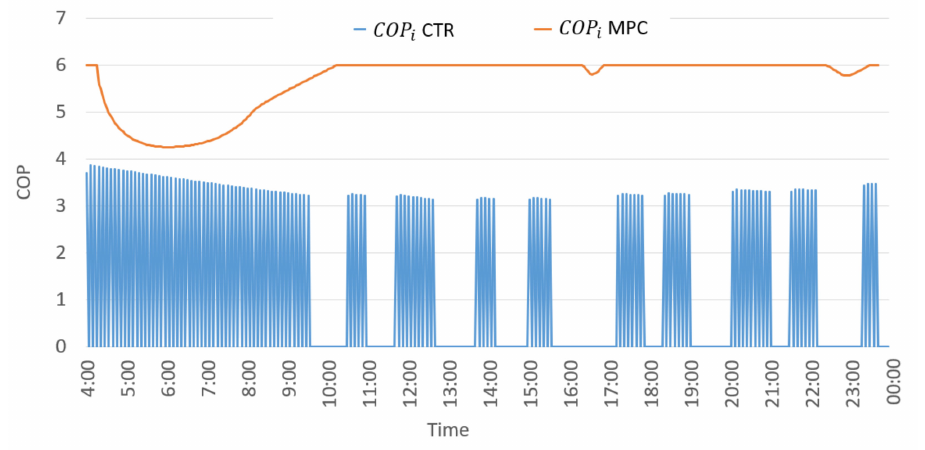
Figure 11. COP i values in the MPC vs. reactive methods (RM). In Figure 12, the behavior of the state variables T g associated with the indoor temper- i ature are displayed for different values of the parameter γ in the MPC and of parameter crt in the reactive method (RM). Imposing small values of the control parameter crt in the reactive method, Equation (12), the T g fluctuation is reduced in time and in extension i (see, as an example, T g in RM for crt = 0.2). In those cases, the HP activation is reduced, i decreasing the energy consumption but, also, leading to a failure in keeping track of the temperature during most of the time horizon. Besides, the comparison between the MPC approach and reactive method performance was carried out by varying the weighted parameters in the multiobjective optimization control model. In particular, the controller design based on the weighted sums of the three objectives in the optimization model was decomposed in its components. The two approaches were evaluated with respect to the second ( OBJ 2, Equation (1b)) and the third objectives ( OBJ 3, Equation (1c)), respectively, associated with the minimization of the electric power Pel i and the minimization of the maximum value of deviation between the current indoor air temperature in the greenhouse and the target one.